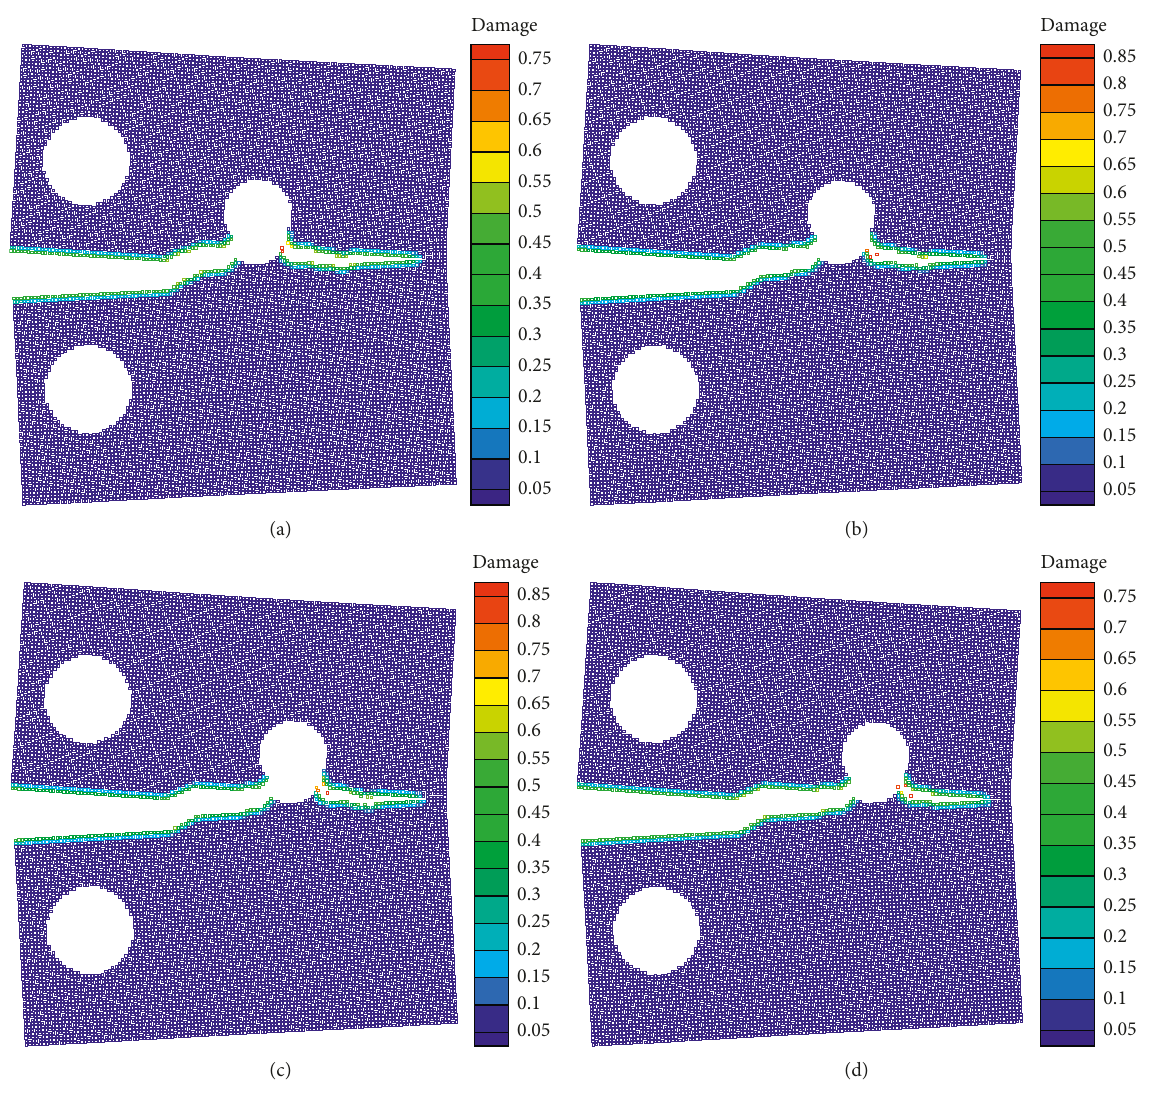
Figure 17: Crack paths with different hole horizontal positions when y � 15mm and (a) x � 25mm, (b) x � 30mm, (c) x � 35mm, and (d) x �